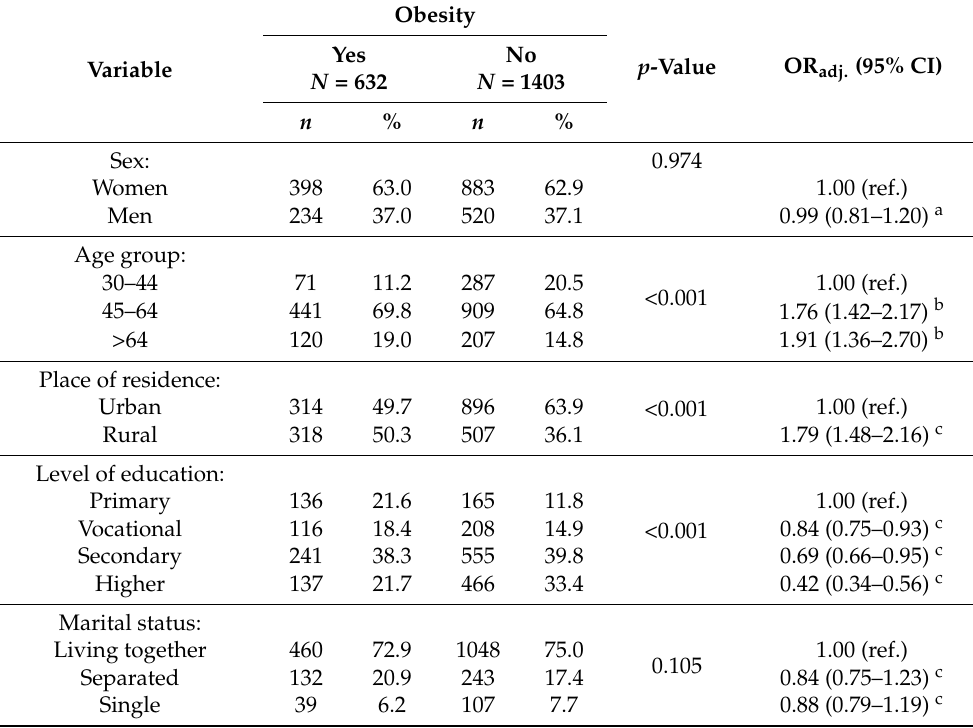
Table 2. The adjusted odds ratio (OR) of the occurrence of obesity in the study